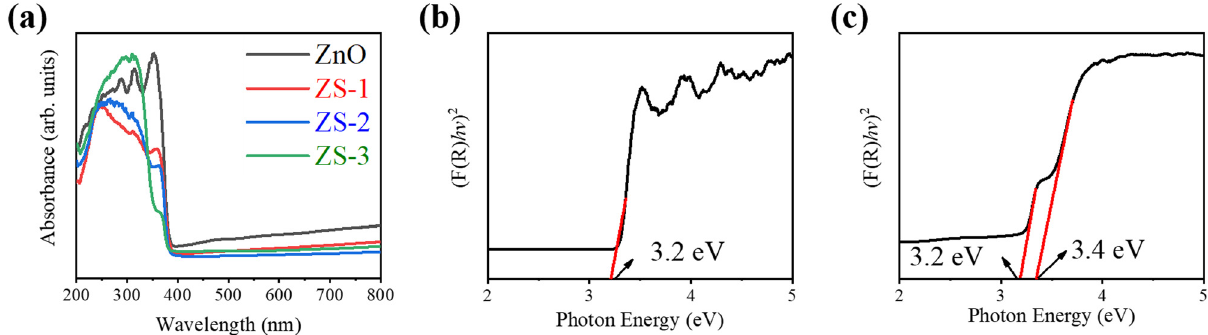
Figure 7: ( a ) UV - Vis absorption spectra of various products. ( b ) The band gap evaluation of the ZnO template. ( c ) The band gap evaluation of ZS -